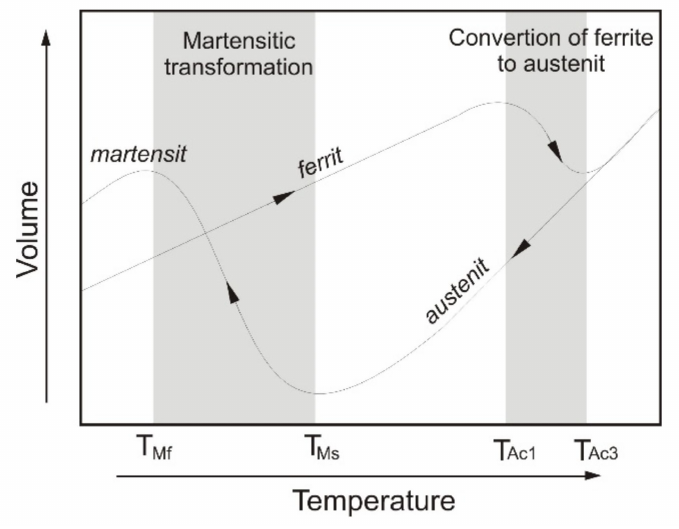
Figure 3. Diagram of material volume changes resulting from structural changes in steel. Reprinted from permission from [15]. Copyright 2007 the Łukasiewicz Research Network—Institute for Sus- tainable Technology.